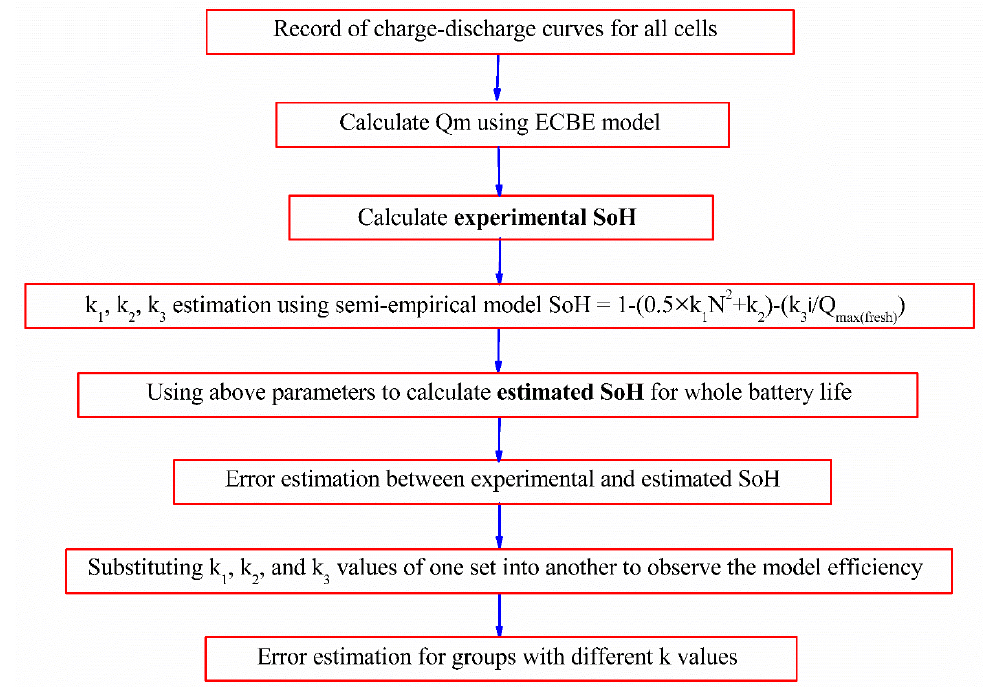
Figure 2. Flowchart for di ff erence estimation between experimental and estimated SoH.